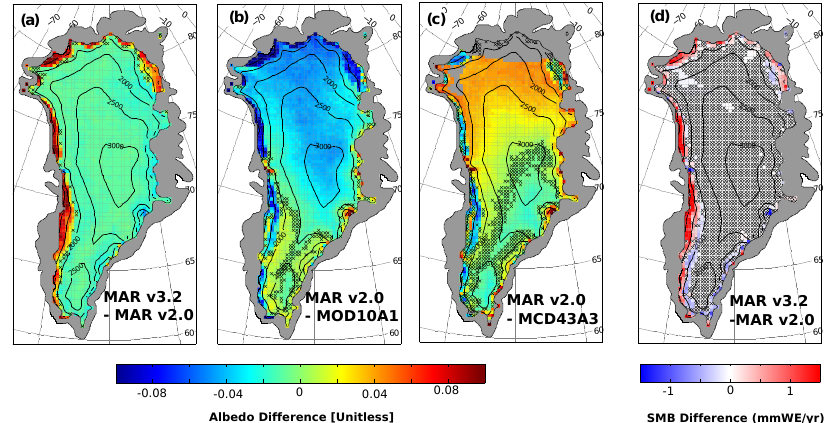
Figure 12. (a) MAR v3.2 clear-sky minus MAR v2.0 clear-sky mean JJA albedo (b) MAR clear-sky v2.0 minus MOD10A1 2000–2012 mean JJA albedo, (c) MAR clear-sky v2.0 minus MCD43A3 BSA SW 2000–2012 mean JJA albedo, and (d) MAR v3.2 minus MAR v2.0 mean JJA SMB (mWEyr − 1 ) for the same period. Note that in the ablation area, where net SMB is negative (Fig. 1), a positive SMB bias indicates a net mass loss that is reduced in magnitude. Grid boxes where differences are not significant at the 95% confidence level are marked with a black